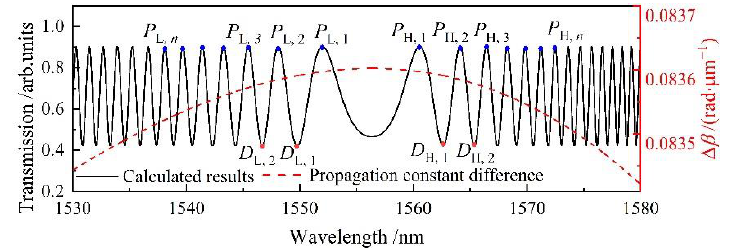
Figure 3. The simulated curve of the propagation constant difference ∆ β of LP 01 and LP 02 modes propagating in the few-mode fiber, and the transmission spectrum of the SFS structure ( L FMF = 50 cm) under the temperature of 25 ℃ versus wavelength.